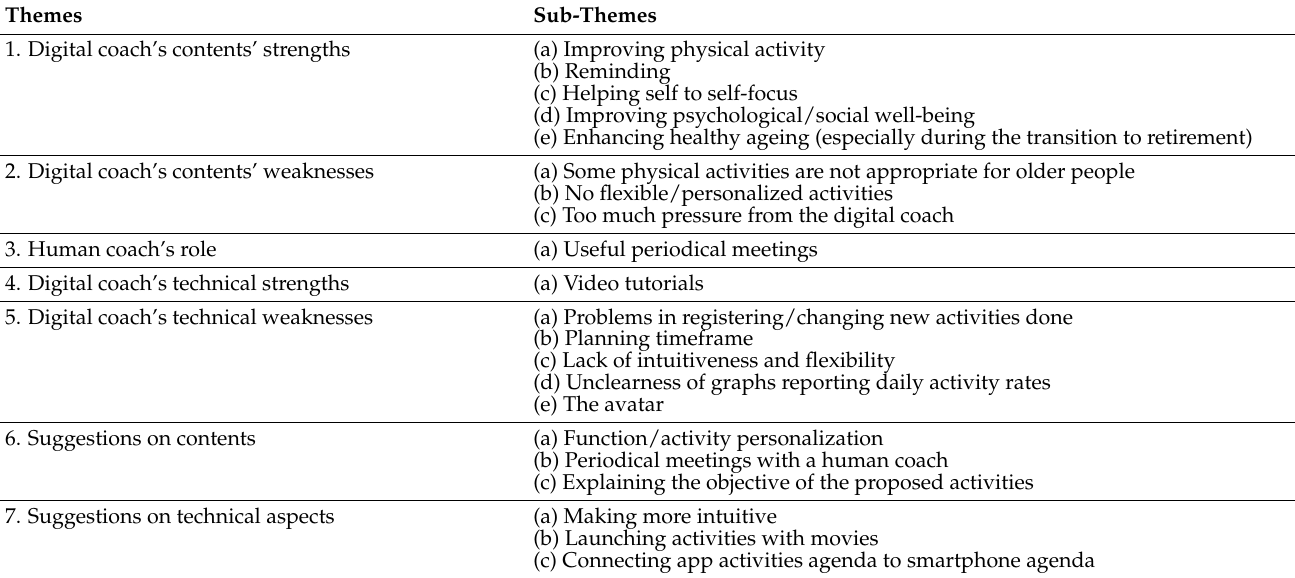
Table 5. Themes and sub-themes that arose from the focus groups with Italian and Dutch